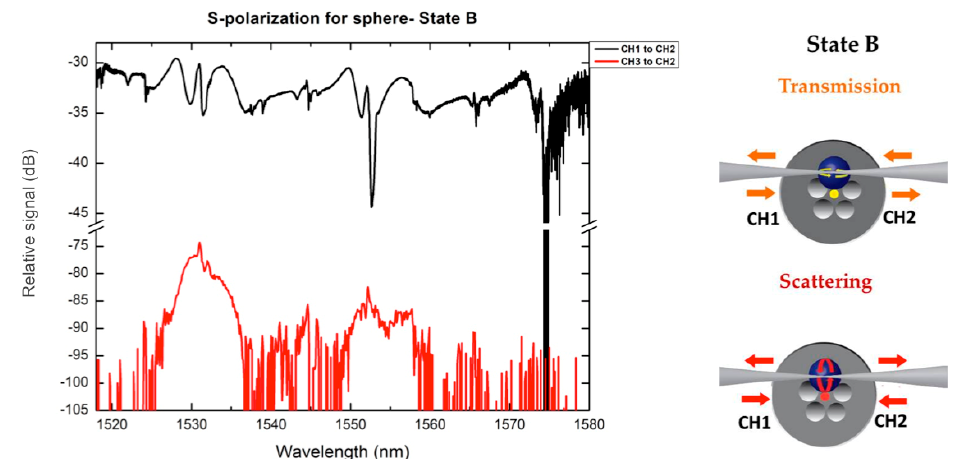
Figure 5. State B: Transmission and corresponding scattering spectra of the T-shape system obtained with the polarizing optical fiber.